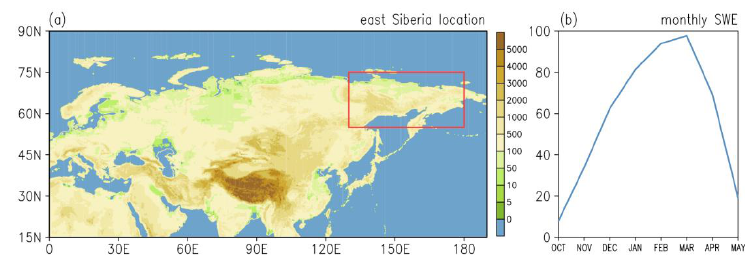
Figure 1. ( a ) Location of east Siberia (red box covered area) and ( b ) climatological monthly mean SWE (mm) in east Siberia from October to May. Shading in ( a ) denotes the elevation (m).